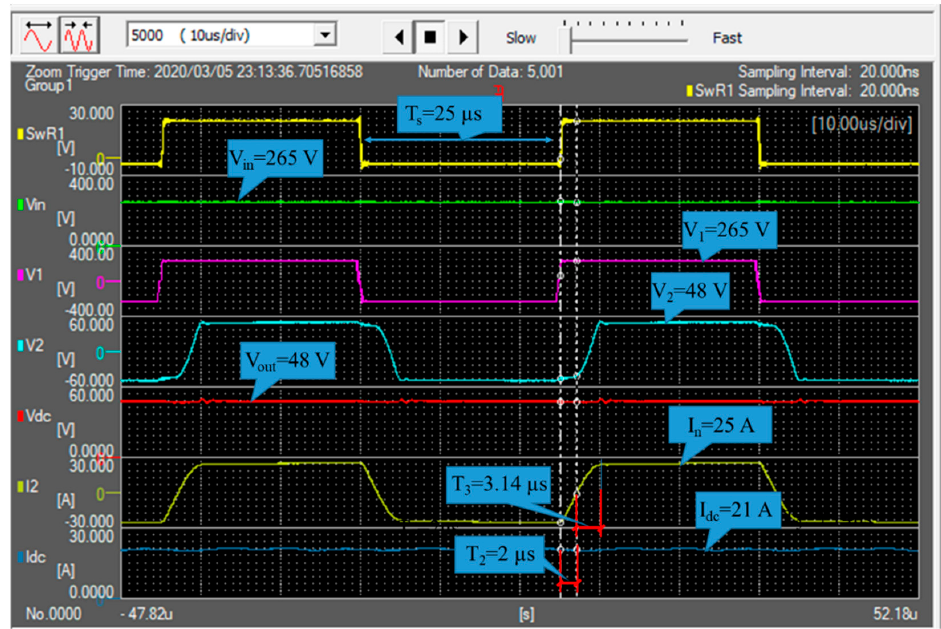
Figure 9. Experimental voltage and current waveforms at (cid:1858) (cid:3046) = 20 kHz .